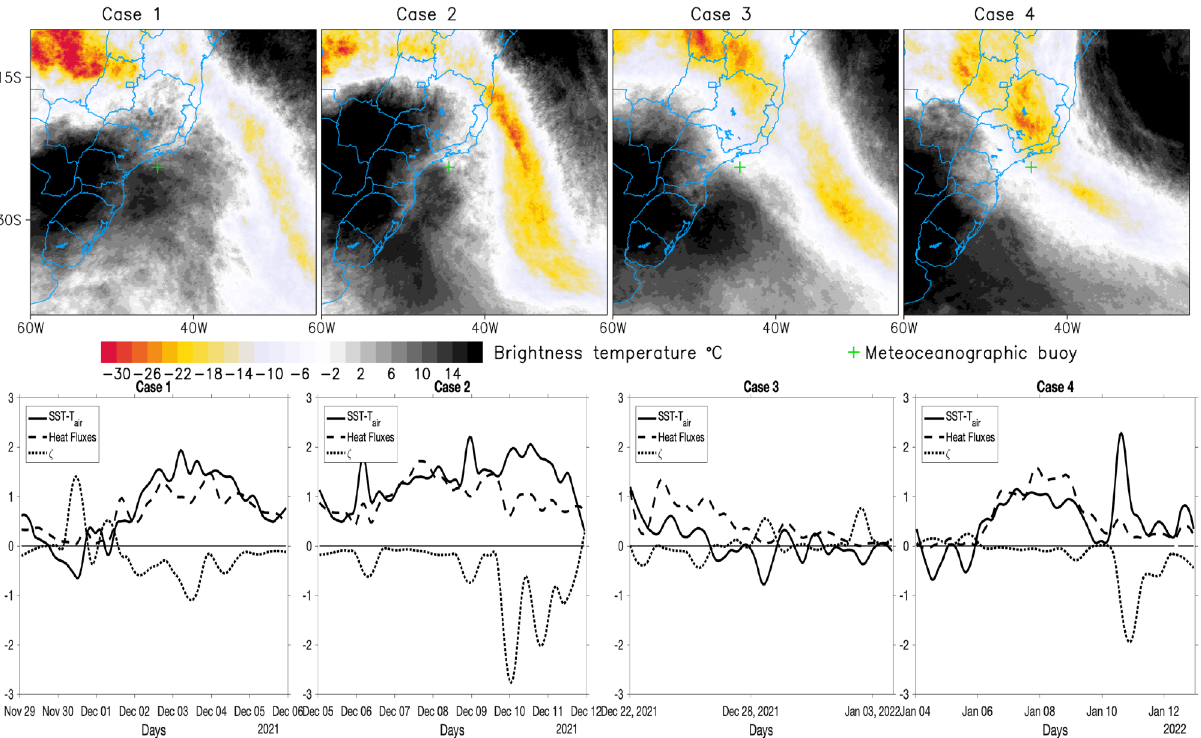
Figure 7. Satellite brightness temperature composites (°C) (top panel) for the SACZ cases 1 to 4 and corresponding in situ buoy measurements (bottom panel) of Heat Fluxes (Ql + Qh)/100 W m −2 and SST-T air (°C) and Monin–Obukhov (ξ = Z/L) stability parameters (dimensionless). The green cross in the satellite images indicates the position of the Cryosphere meteoceanographic buoy. Grid Analysis and Display System